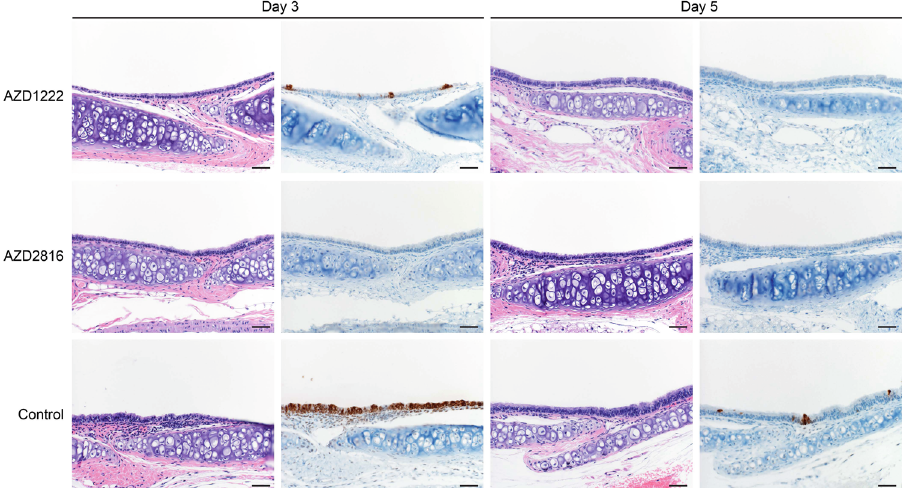
Fig. 7 | Effectsofintranasalchallenge withthe OmicronVoC ontracheal tissue invaccinatedandcontrolhamstersatdays3and5postchallenge. H&Estaining (1 st and 3 rd column) and IHCstaining against N protein (brown, 2 nd and 4 th column), 20x, scale bar=50 µ m. N =4. In animals that received an AZD1222 vaccination, minimalpathologyinoneanimalandrareimmunoreactivityin3/4wasobservedon